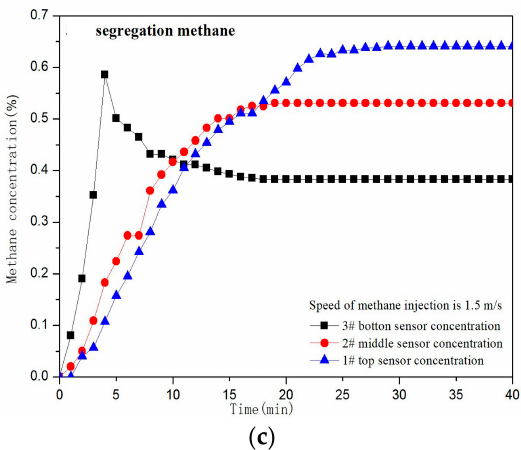
Figure 3. Graph of the segregation methane concentration versus time in the enrichment tower. ( a ) Speed of methane injection is 0.5 m/s; ( b ) Speed of methane injection is 1.0 m/s; ( c ) Speed of methane injection is 1.5 m/s